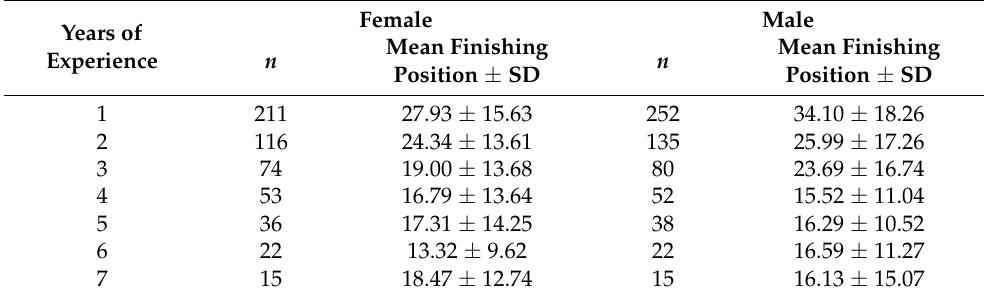
Figure 1. Age of successful ( a ) men and ( b ) women participants in the World Swimming Championships (WCH) or Olympic Games (OG) 10-km open water races from 2000 to 2019. Note: “WCH 00” refers to the 2000 edition, “WCH 01” to the 2001 edition, etc. Table 1. Years of accumulated experience (from one to seven) and average finishing positions of swimmers in the 10-km races of the WCH and OG since 2000.